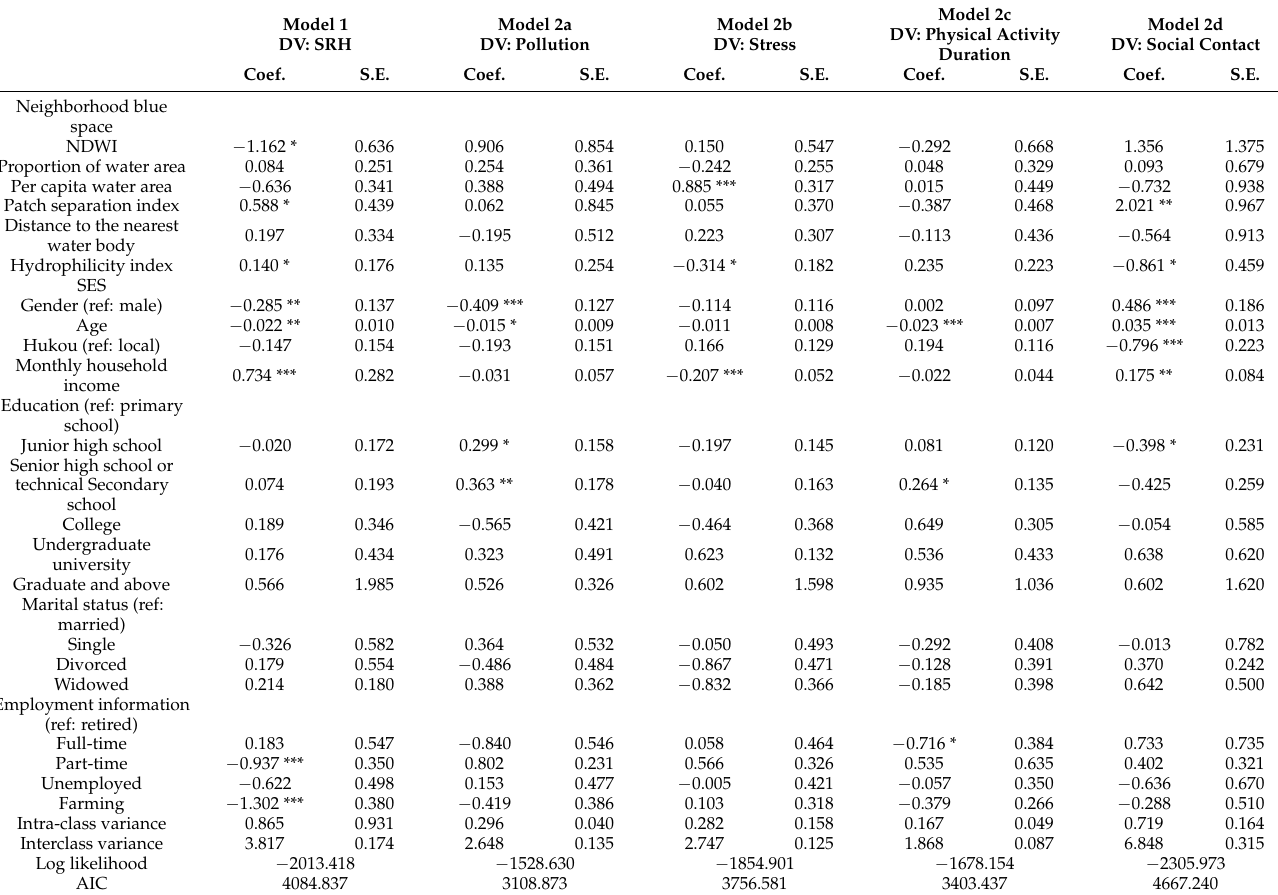
Table 3. Associations between neighborhood blue space and elderly’s SRH (possible mediators). Model 1 DV: